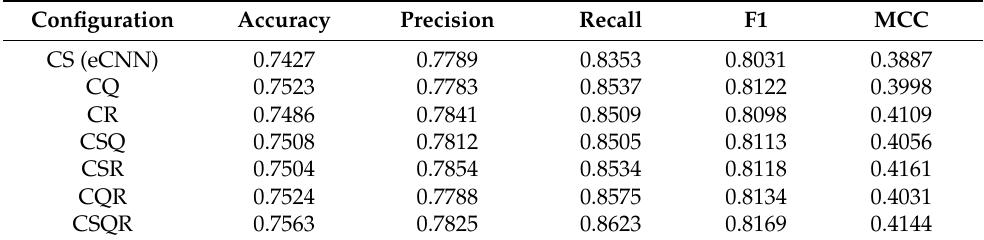
Table 9. Average prediction performance of various configuration of